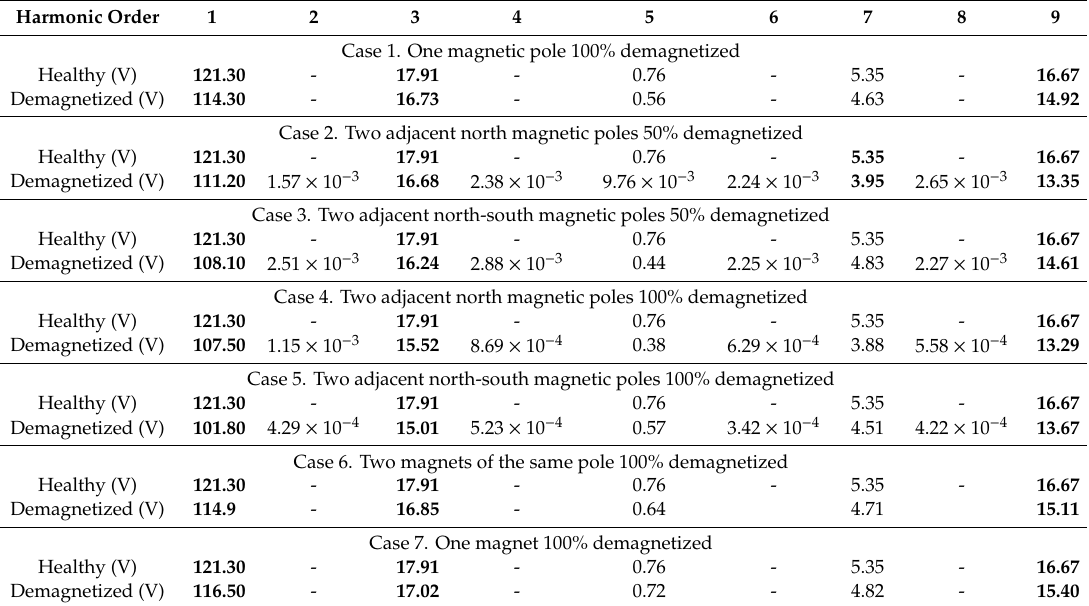
* Bold numbers indicate the most discriminating